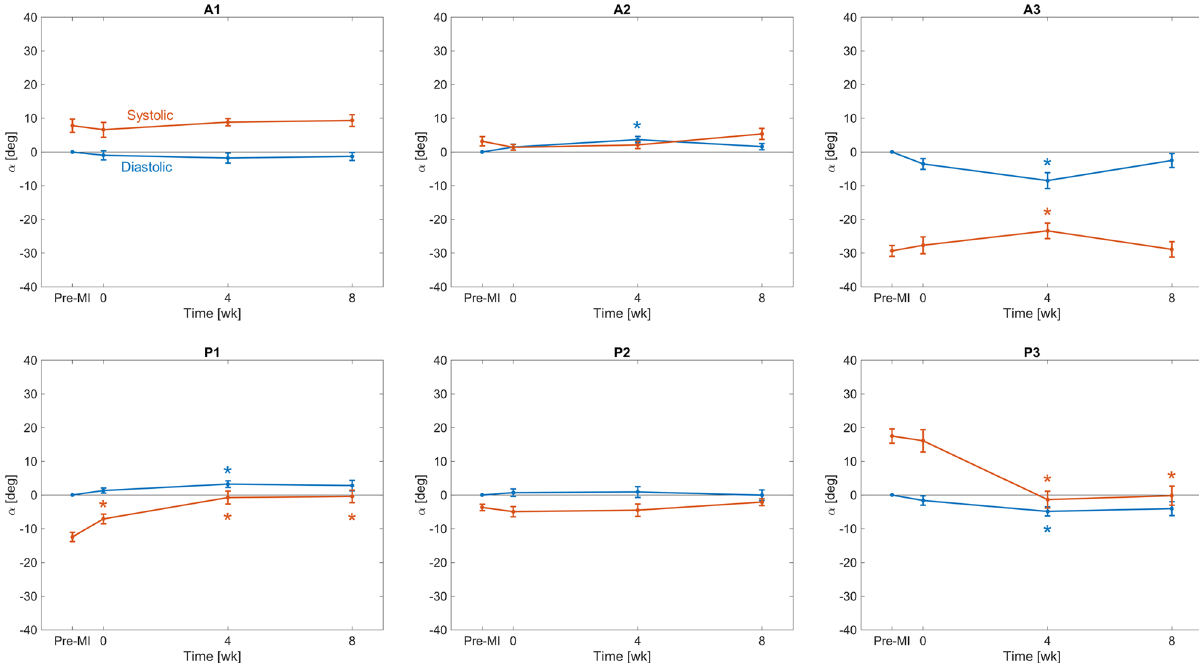
Figure 8. Shear angle in both diastole and systole for each Carpentier leaflet segment, referenced to the pre-MI diastolic configuration. Lines and error bars at each time point denote the mean and standard error across n = 8 specimens. Asterisk symbols (*) denote statistically significant differences from the corresponding pre-MI value with 95% confidence ( p < 0.05 yielded by a paired t